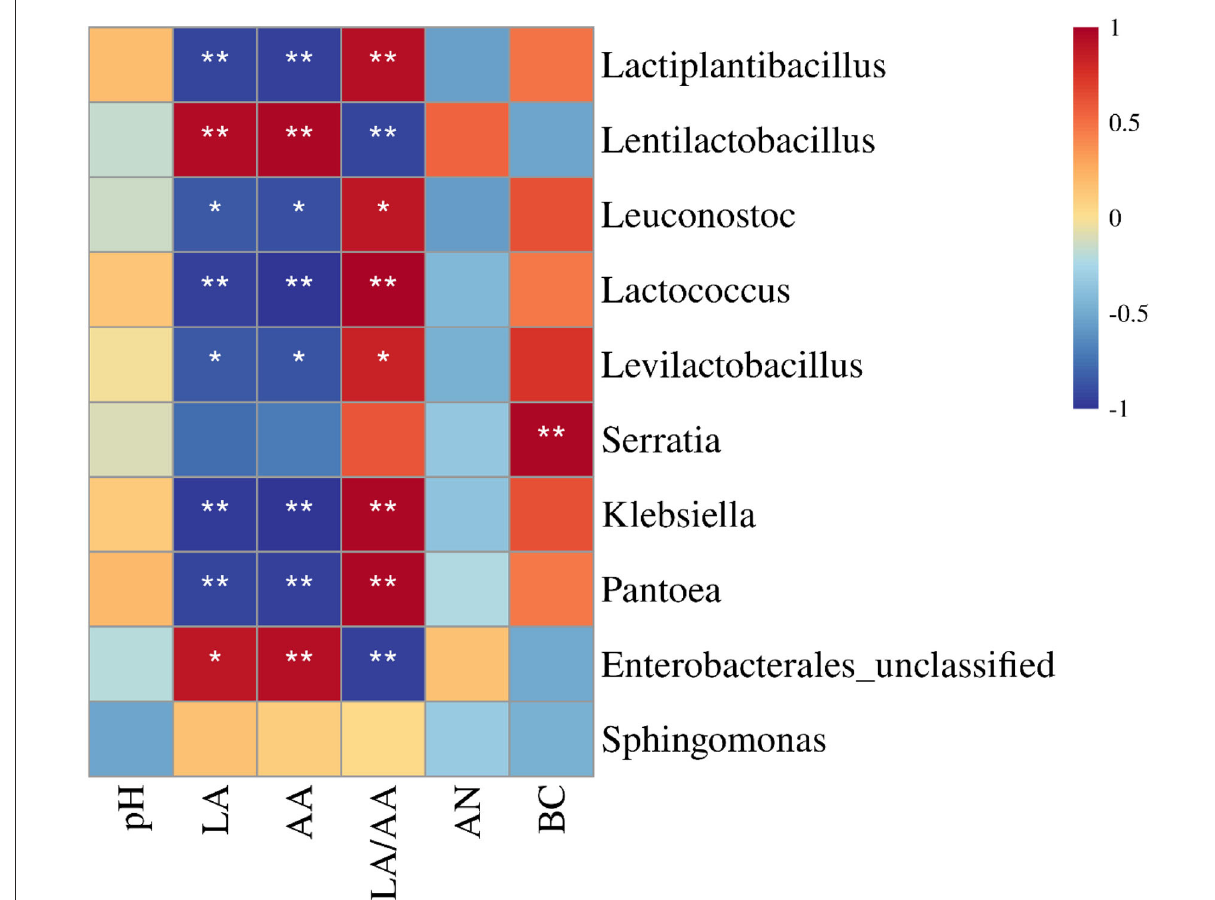
FIGURE4 Correlation heatmap between main bacterial genera (top 10) and fermentation quality of sweet sorghum silages ( n = 6). LA, lactic acid; AA, acetic acid; AN, ammonia nitrogen/total nitrogen; BC, buffering capacity. * p < 0.05 and ** p <